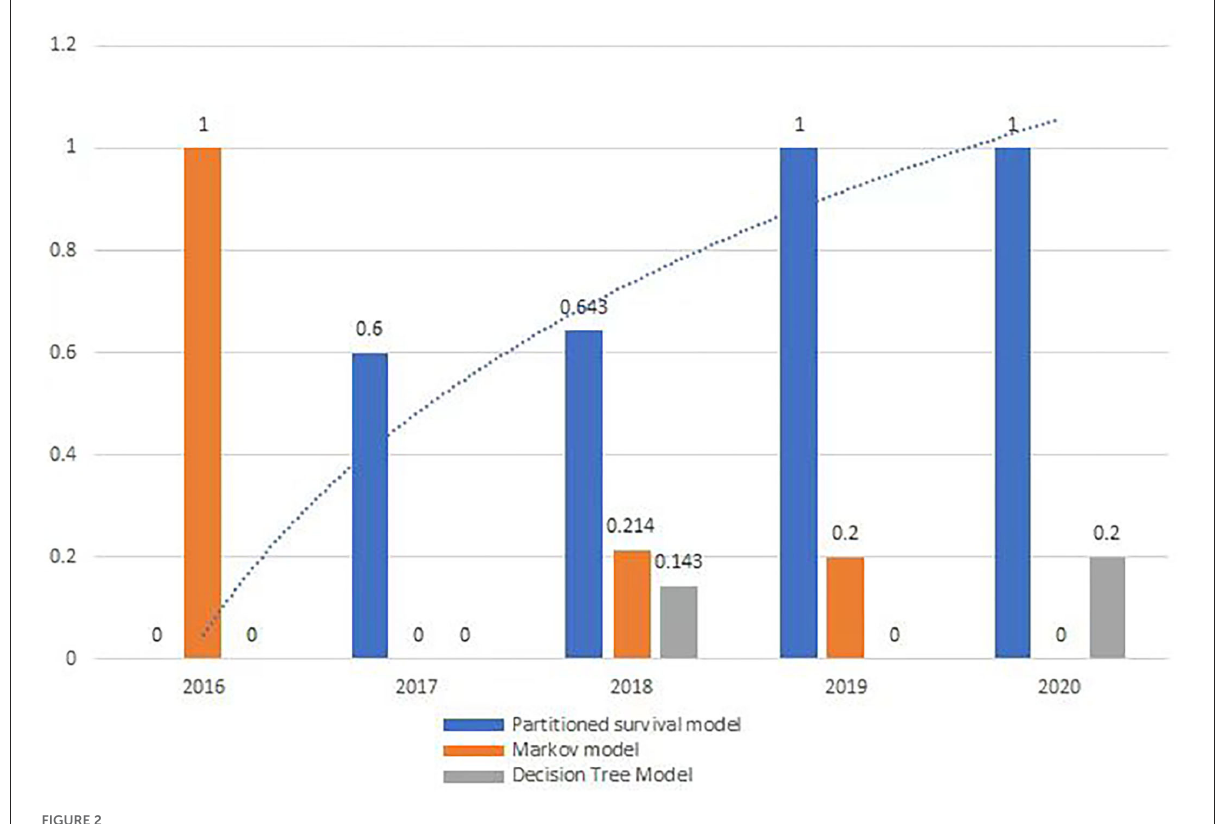
FIGURE2 The usage of partition survival